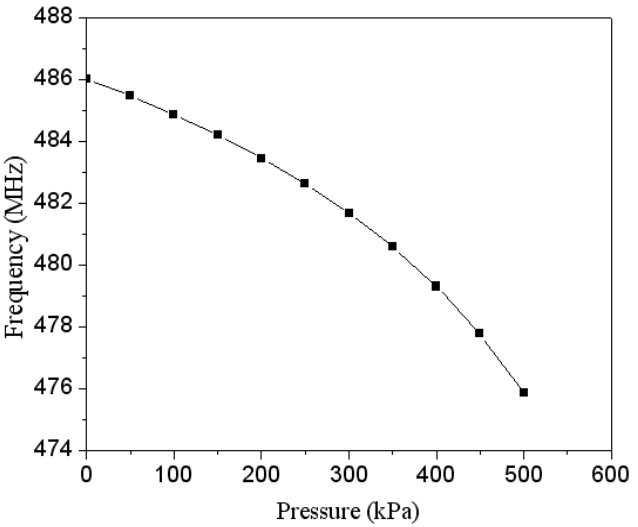
Figure 5. Simulated results of output frequency in the pressure sensor with ring